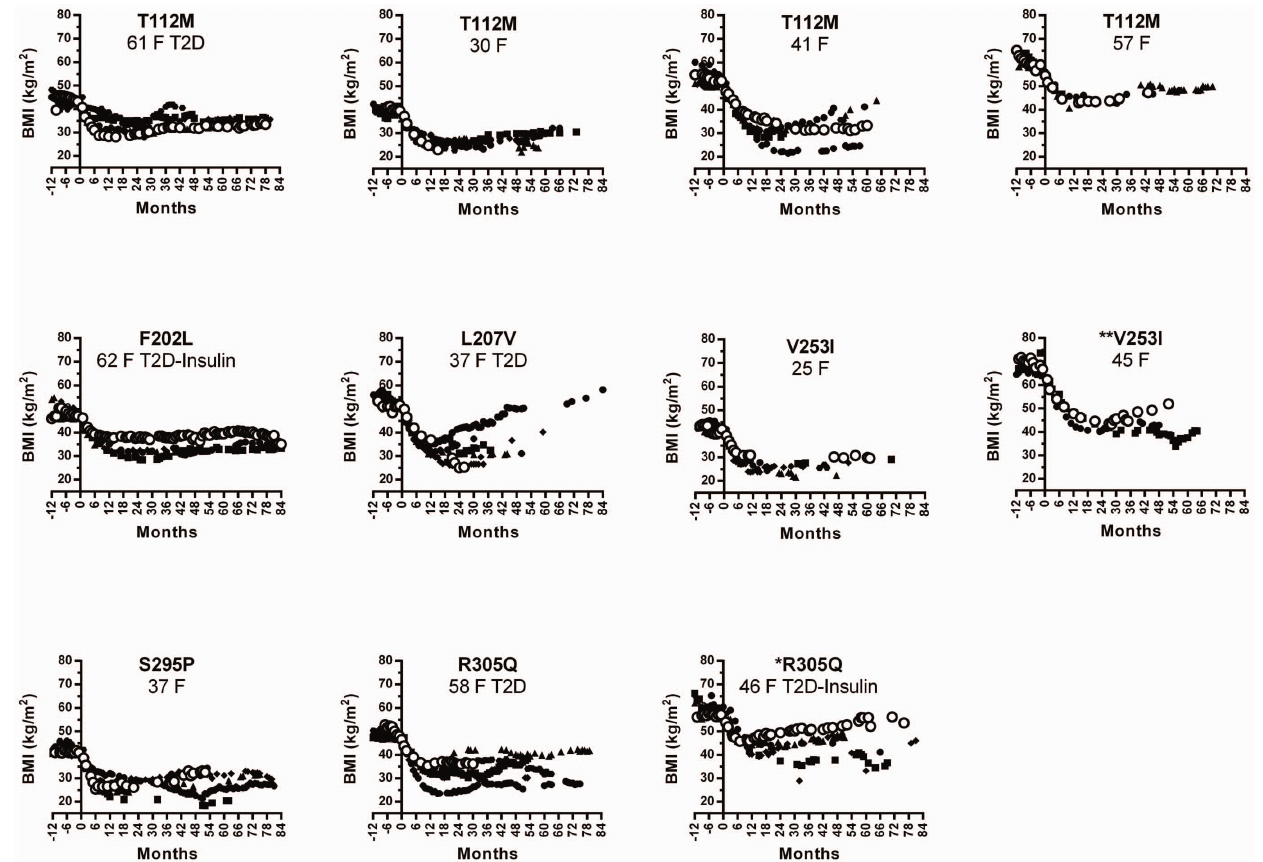
Figure 1. BMIs of patients with rare variants reported in both obese and lean populations. The pre-surgery BMIs of patients with rare variants were matched with non-carrier patients of the same gender, T2D status, insulin medication status and similar age (within 5 years) (black symbols). The variant carrier’s age, sex and T2D status is also listed ( # ). *The starting BMI range for the matches was extended to 6 2. **The starting BMI range for the matches was extended to 6 3 or the age difference extended to 6 8